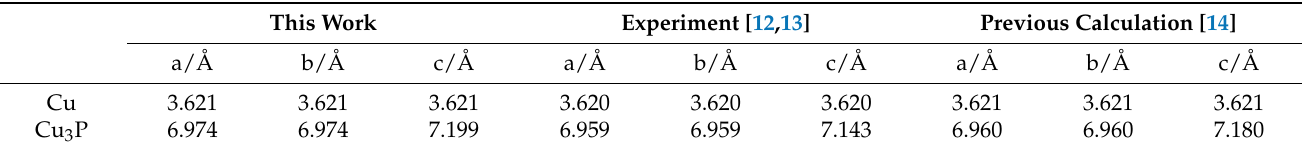
Table 1. Comparison of lattice constants of Cu 3 P and